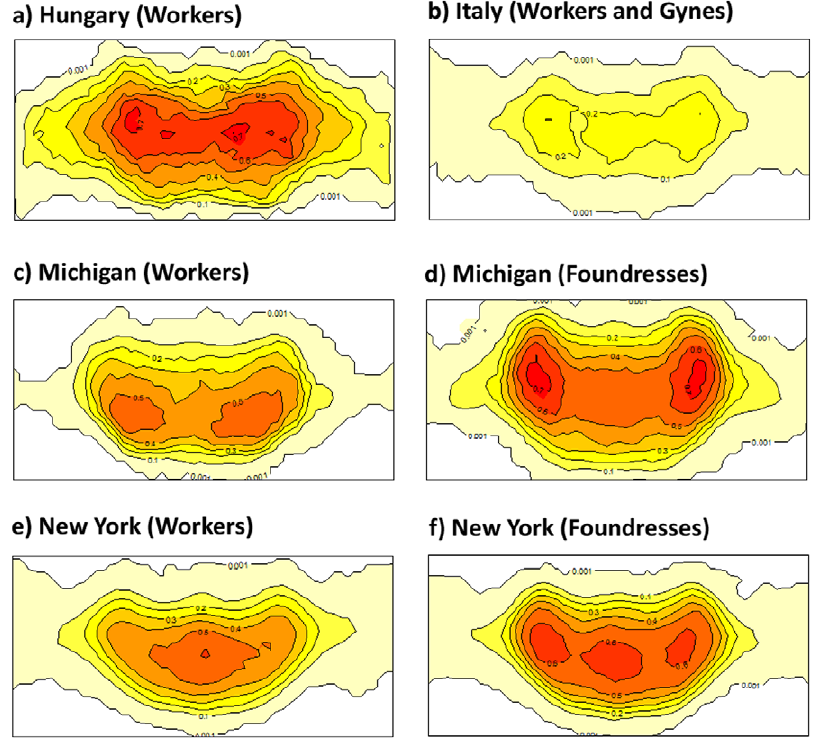
Figure 3. Contour maps of population-level clypeal melanin pigmentation in different groups of wasps. Each contour line represents the percentage of wasps in the population with pigment present in that region of the clypeus. These maps demonstrate that in general pigmentation is most common in central area of the face, that different locations have dramatically different population level patterns of pigmentation, and that workers tend to have less complex patterns than foundresses. Number of photographs used to create the contour maps: a) 42, b) 132, c) 87, d) 147), e) 425), f) 384.